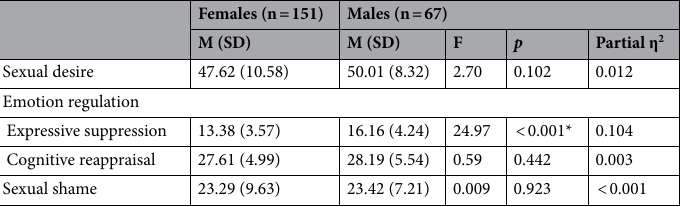
Table 3. Gender differences in expressive suppression, cognitive reappraisal, and sexual shame on sexual desire. SD standard deviation. * p <